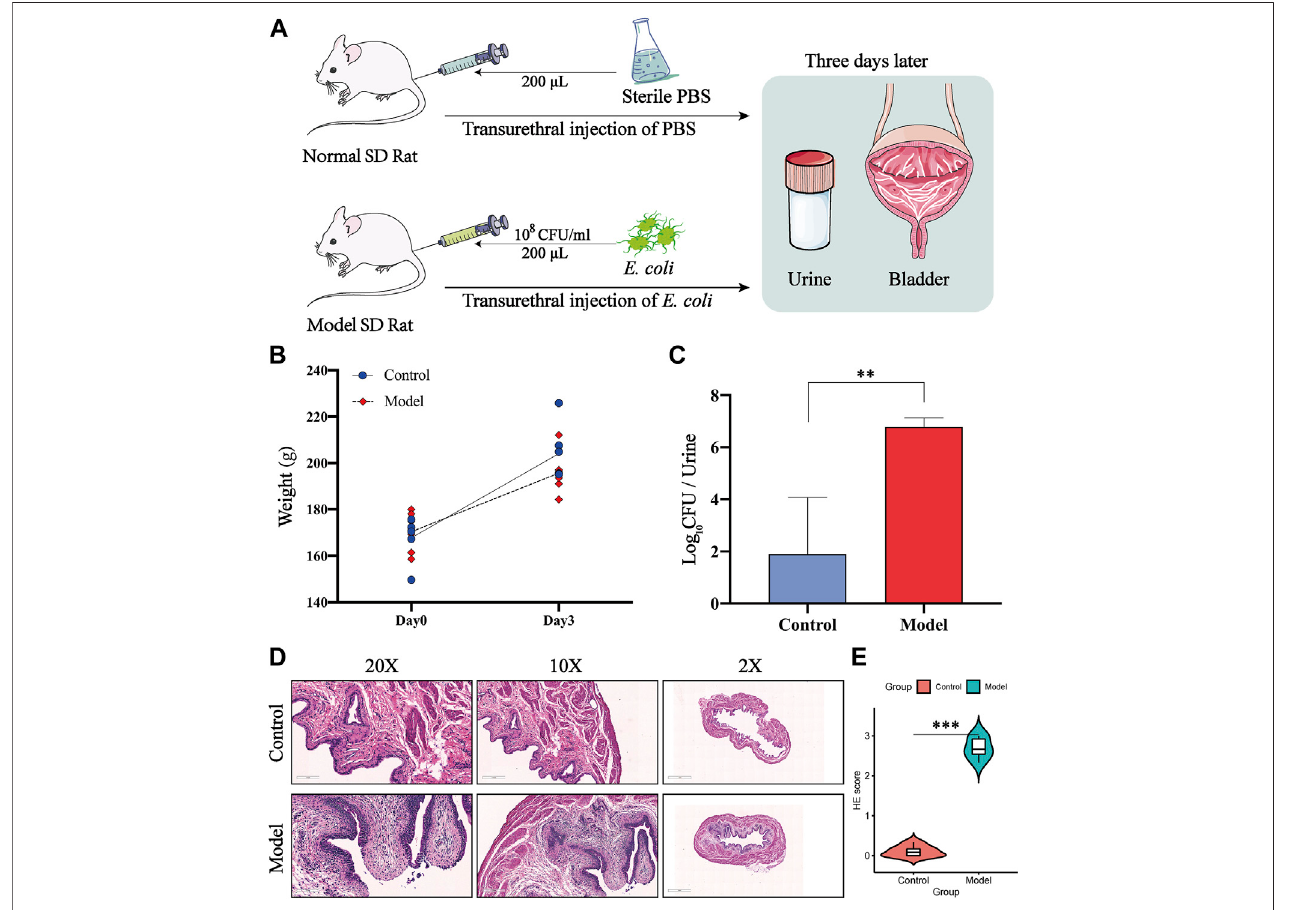
FIGURE 8 | Construction of a successful UTI model by transurethral injection of E. coli . (A) Animal experimental design of transurethral injection of E. coli to induce theUTImodel; (B) bodyweightsofthecontrolgroup( n (cid:1) 6)andmodelgroup(n (cid:1) 6); (C) levelofbacterialburdeninurineamongtwogroups; (D) representativeimagesof H&Estainingofparaf fi n-embeddedbladdersectionsfromtwogroups;allbladdersampleswerestainedusinghematoxylin – eosin( × 200magni fi cation,scalebar:100 μ m; × 100 magni fi cation, scale bar:200 μ m; × 2 magni fi cation, scale bar:1 mm); (E) semiquantitative data of H&E staining in fl ammatory scores among groups. All presented values were expressed as means ± S. D, n (cid:1) 6. ** p < 0.01, and *** p < 0.001 compared with the normal control